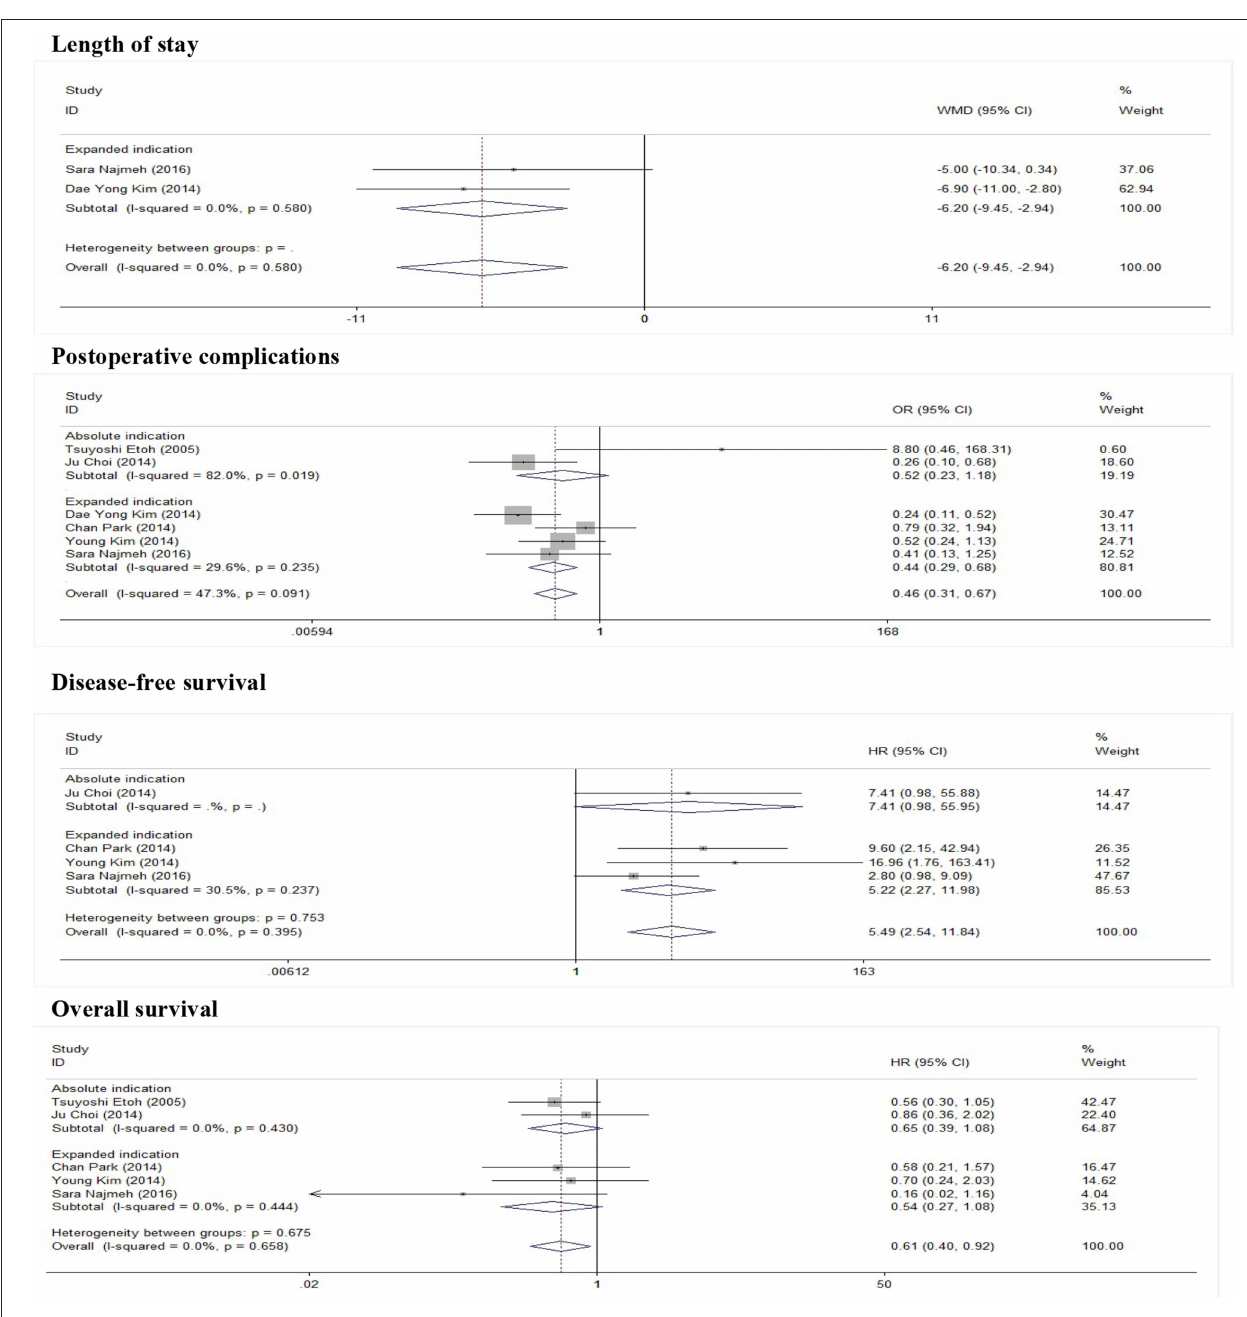
treatments for recurrence lesions should be considered in early gastric cancer patients after ER, but the current studies did not show any adverse event after additional endoscopic treatments for metachronous lesions, and the overall survival of early gastric cancer was no significant difference between ER and gastrectomy. In the subgroup of expanded indication and ESD, there was also a significant difference in disease-free survival between ER and gastrectomy ( Figures 3 , 4